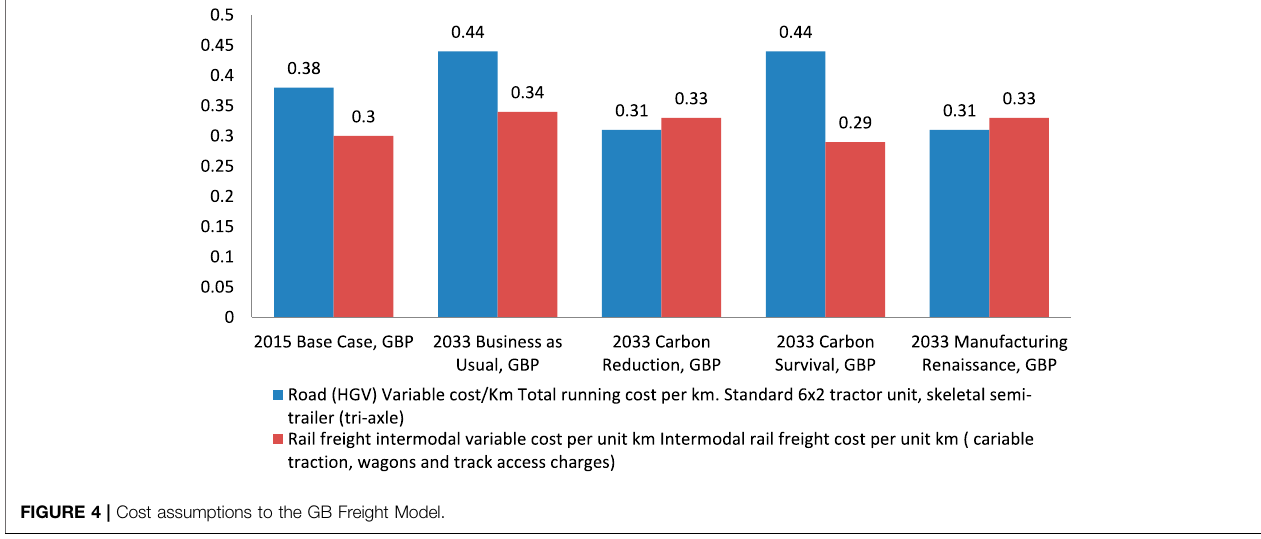
FIGURE 4 | Cost assumptions to the GB Freight Model.